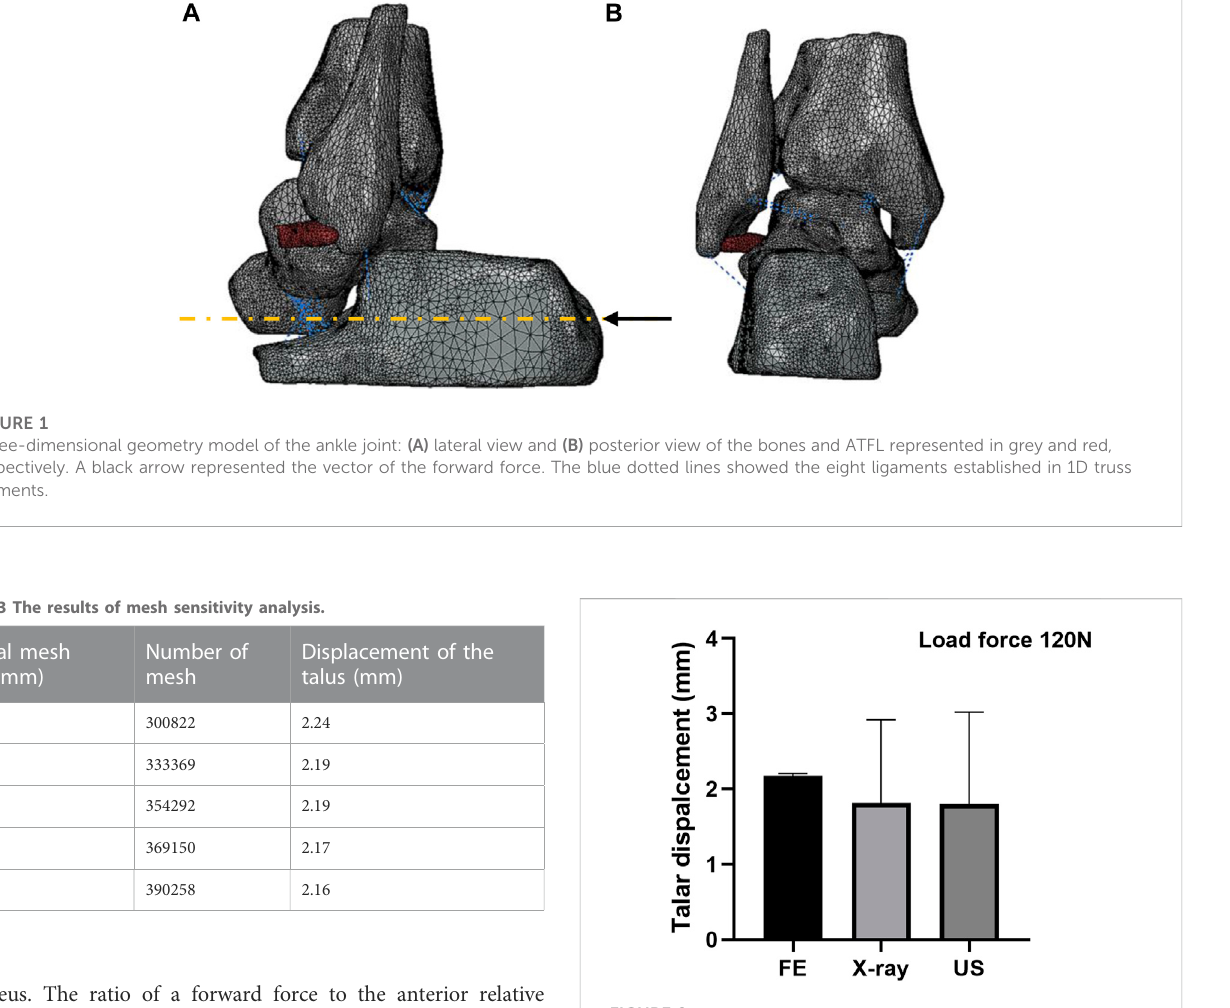
FIGURE 2 Validation of the FE model by comparing with the reference data measured using ultrasound and X-ray (Tsutsumi et al.,